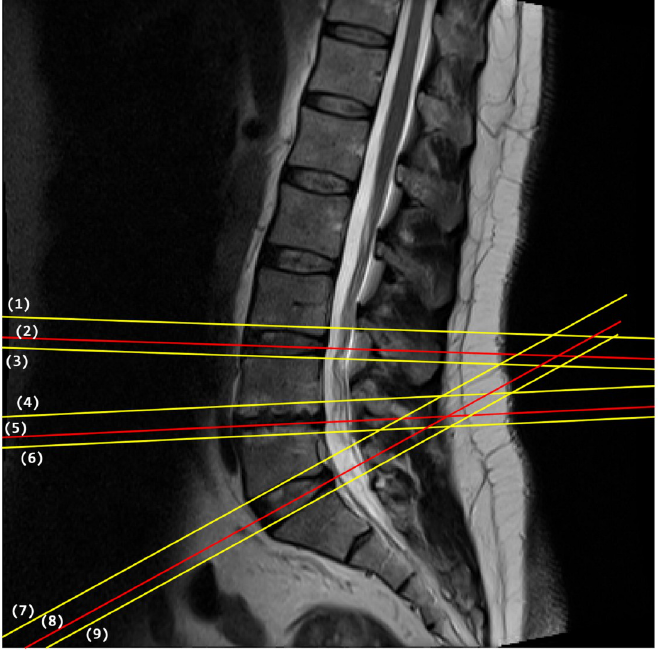
Fig 2. A mid-sagittal view of a lumbar spine MRI showing the intersection lines between the sagittal plane and the traverse planes that are shown in Fig 3. The lines marked in red are the intersection lines of traverse planes that cut closest to the half-height of an